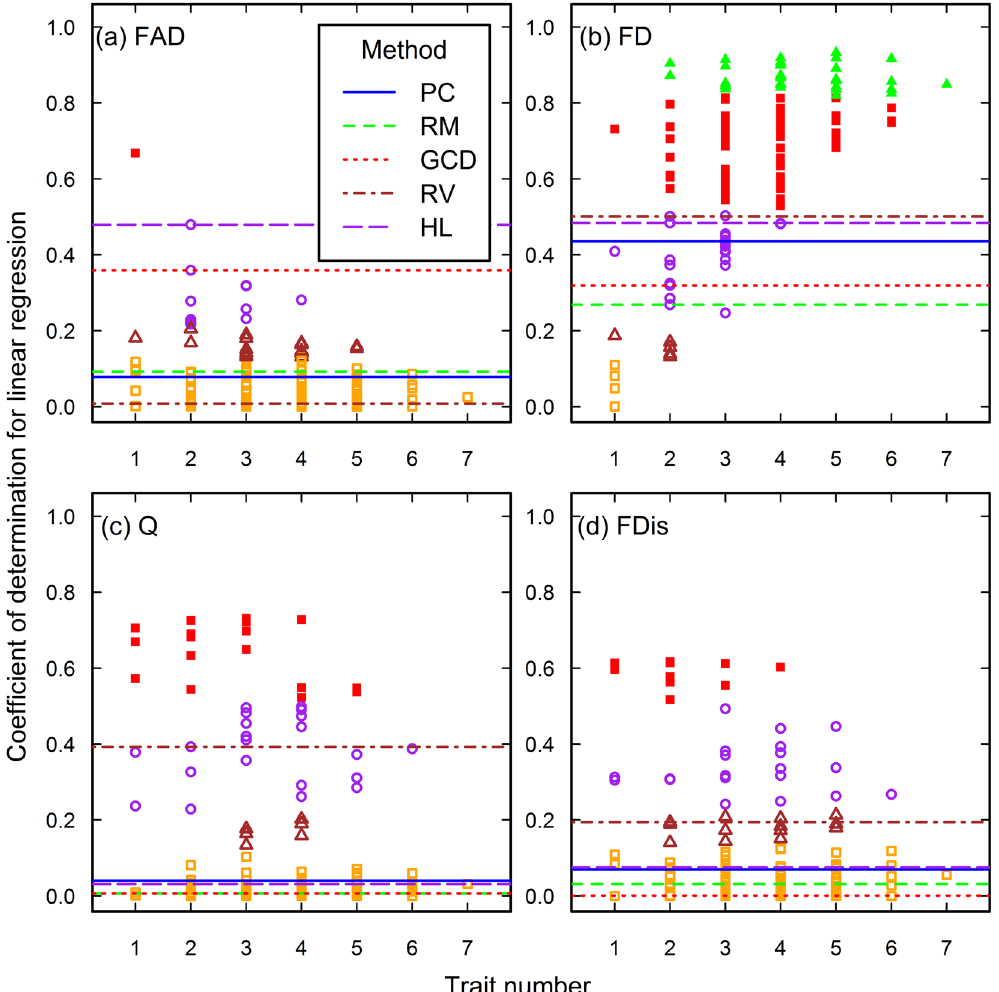
Figure 7. The closeness of associations between species richness and functional diversity in the Mount John data set. See the caption of Fig. 1 for the meanings of each plot, line and